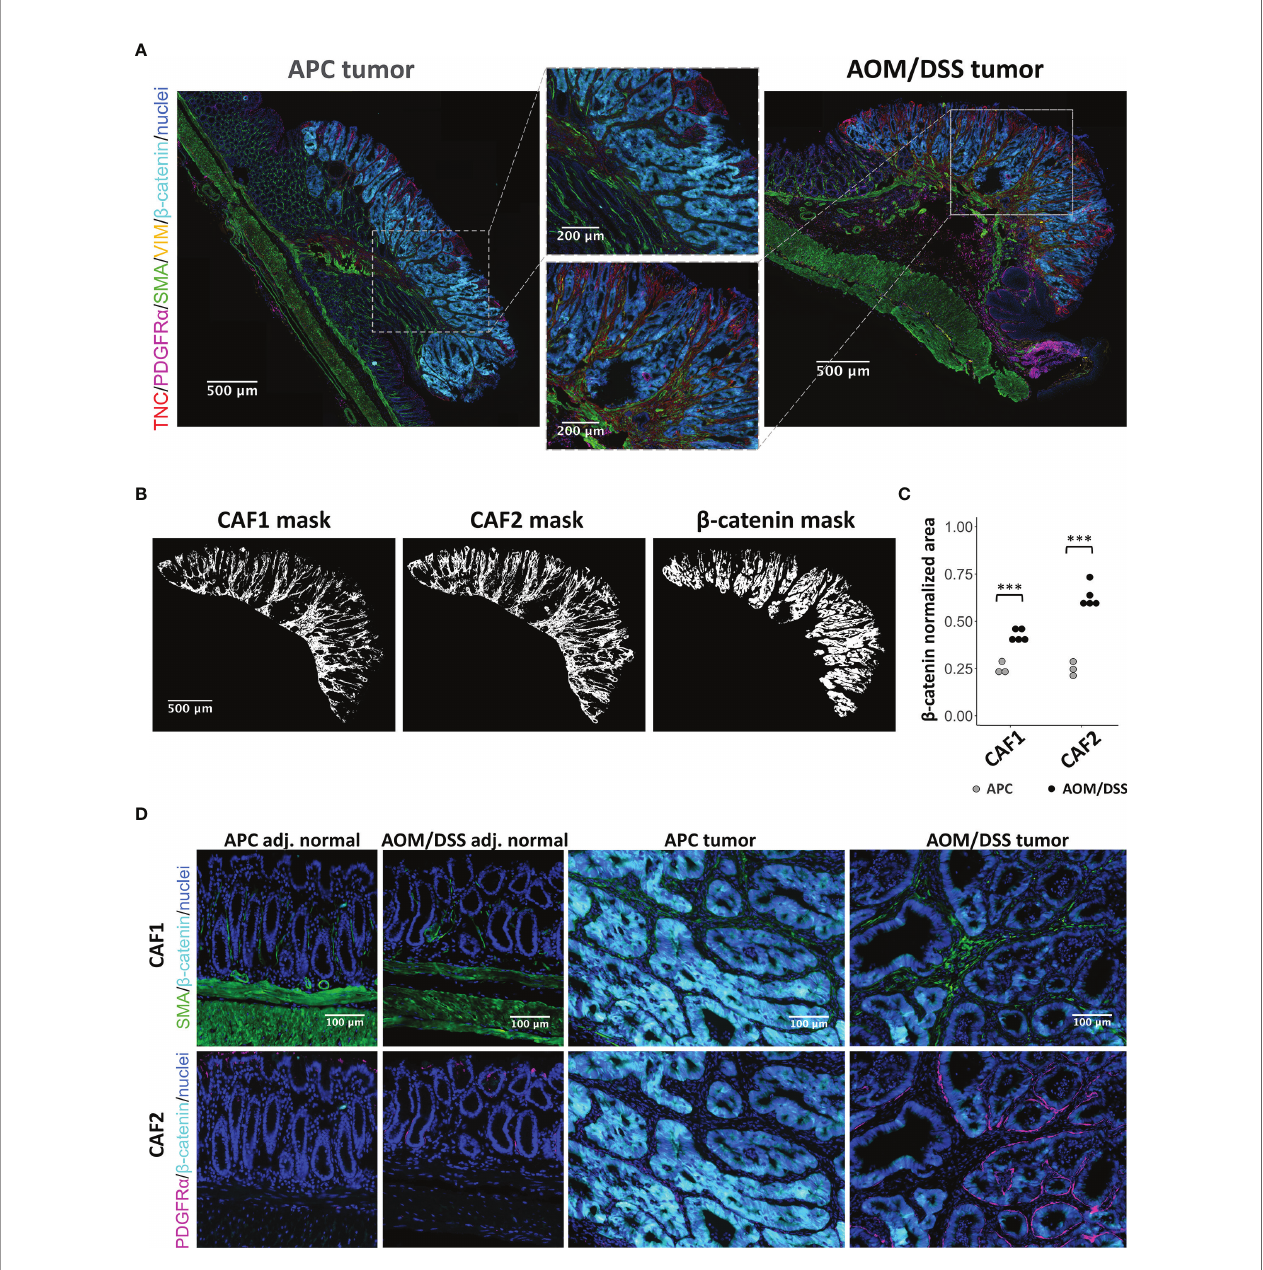
FIGURE 3 | MxIF of cancer-associated fi broblasts to reveal their spatial distributions in APC and AOM/DSS tumors. (A) Representative stitched MxIF images of APC tumors and AOM/DSS tumors immunostained for CAF1 (SMA, VIM) and CAF2 (TNC, PDGFR a ) subtypes. Tumor regions are visualized using immunostaining for b - catenin. (B) Representative binary images (here, AOM/DSS tumor sample) and (C) quanti fi cation of CAF1 and CAF2 marker expression within tumor regions of APC and AOM/DSS samples. n = 5 AOM/DSS tumors, n = 3 APC tumors *** indicates p < 0.001. (D) Visualization of CAF1 (SMA) and CAF2 (PDGFR a ) subtype proximity to b -catenin+ tumor cells in APC and AOM/DSS samples, including tumor regions and adjacent normal